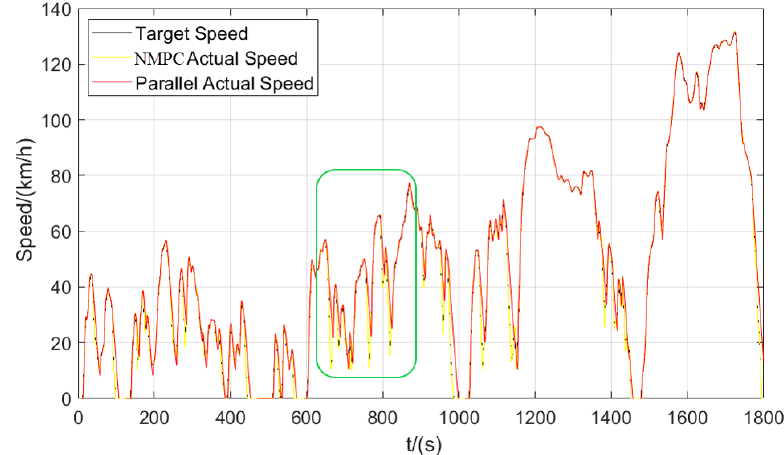
Figure 7. Target speed-time vs. actual speed-time.